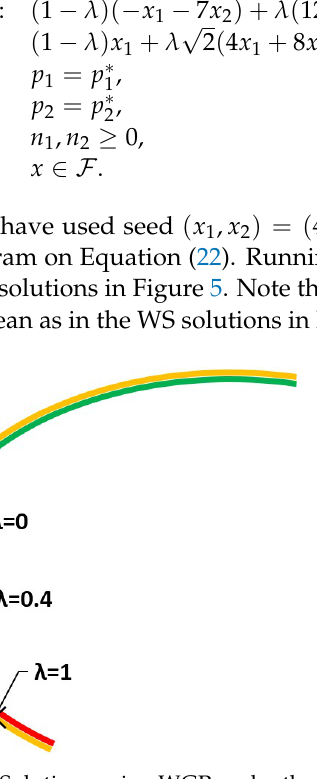
Figure 5. Solutions using WGP under the satisficing philosophy plus straight